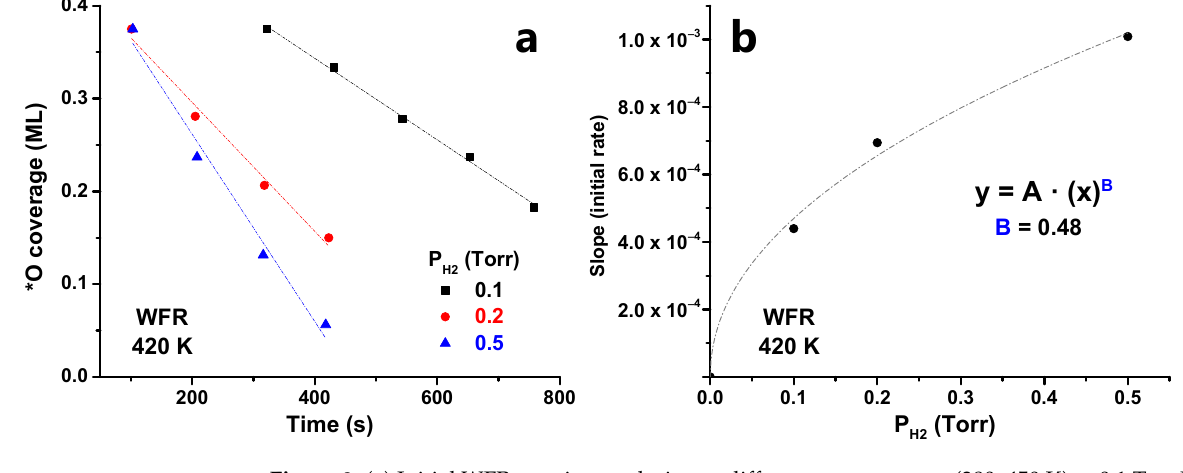
Figure 8. ( a ) Initial WFR reaction evolution at different temperatures (380–450 K) at 0.1 Torr H 2 and ( b ) dependence between the initial rate and the H 2 pressure.